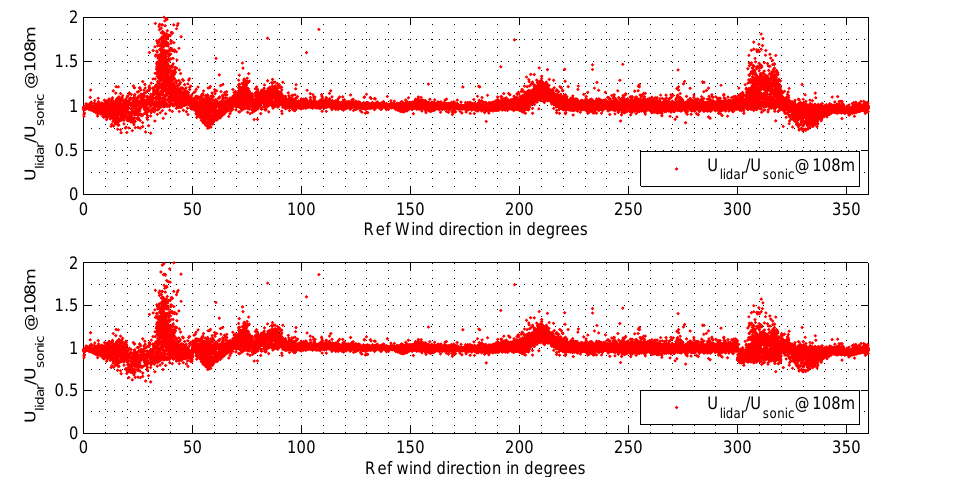
The uncertainty due to the atmospheric lapse rate, Lidar availability and CNR, and precipitation account for an in- dependent uncertainty which cannot be neglected and shall be introduced into the CD IEC 61400-12-1 Ed.2 for power curve standard. The uncertainty in wind speed measurement of Lidar was around 3–4 % and that of sonic anemometer was between 4–5 %. The uncertainty calculated as a result is on the higher side when compared to the ones in the literature. This was expected as more uncertainties have been included into the uncertainty